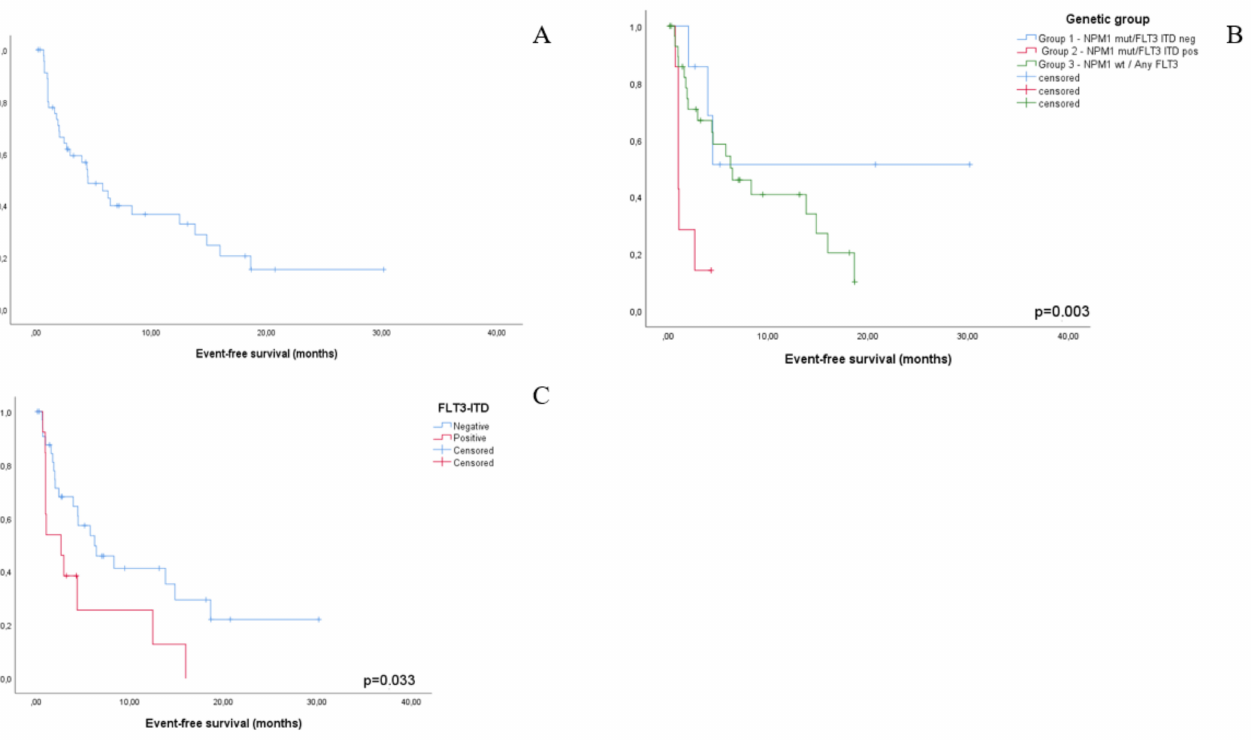
Figure 2. Kaplan-Meier plots representing event-free survival for the whole study cohort ( A ), by NPM1/FLT3-ITD-based genetic group ( B ) and by FLT3-ITD status alone ( C